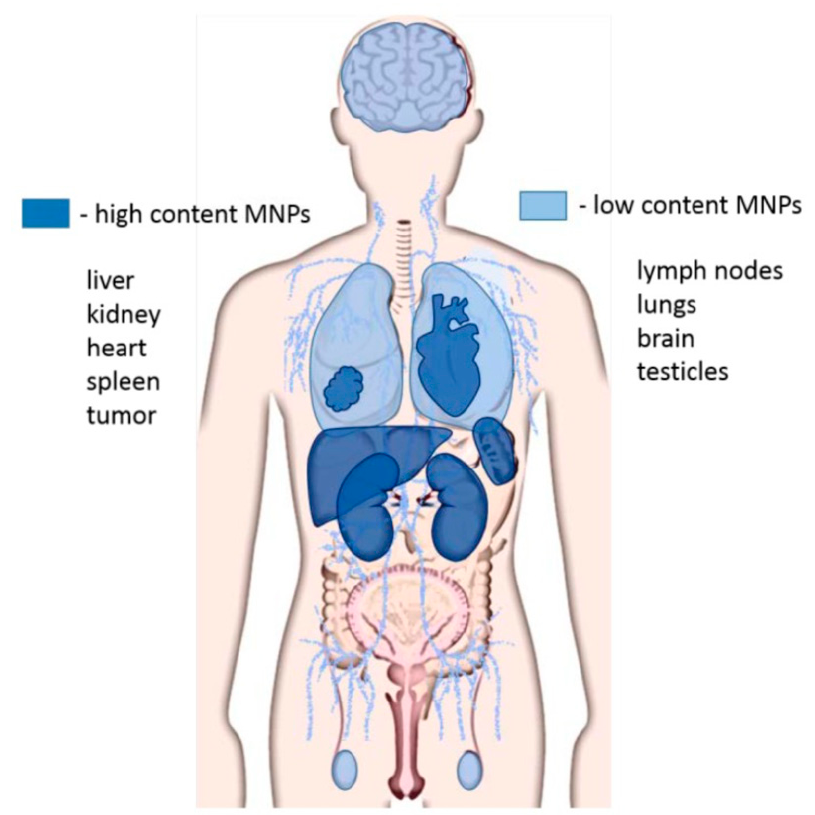
Figure 5. Representation of biodistribution of MNPs in organs and tissues. Unedited image obtained from Zamay et al. [104] following the Creative Commons Attribution (CC BY) license (http://creativecommons.org/licenses/by/4.0/). (accessed on 20 April 2021).